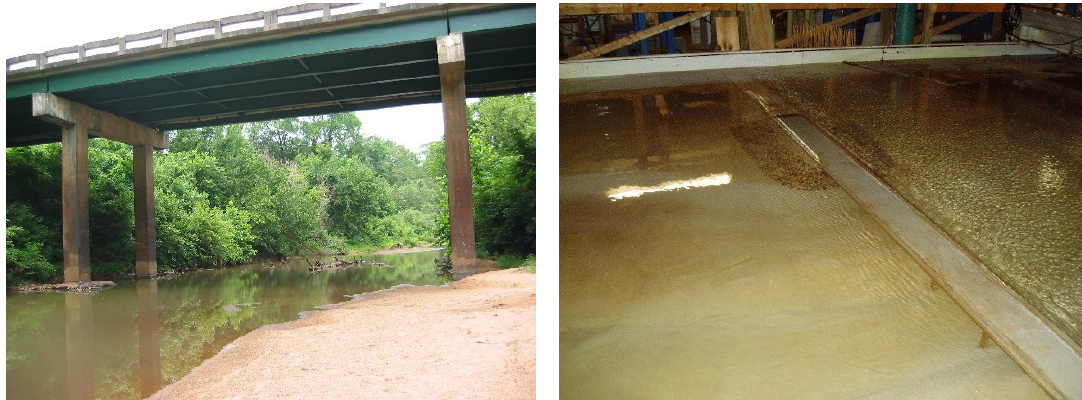
Figure 1. Towaliga River bridge in the field and model in the laboratory.